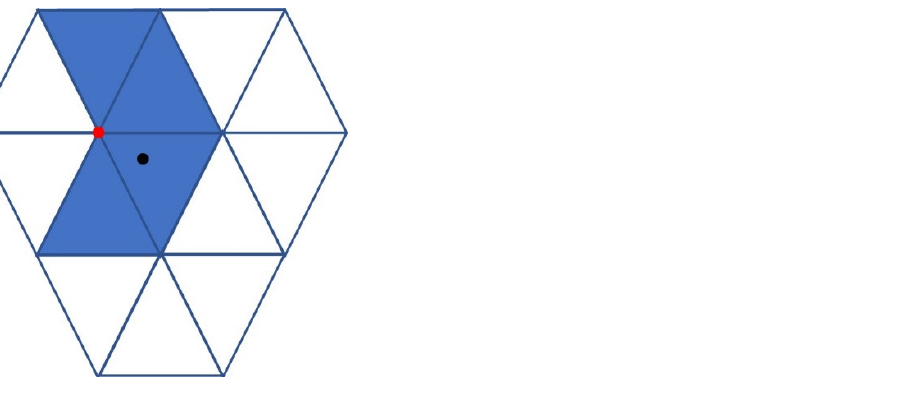
Figure 1. Example of determining the lateral inflows or point sources given the location in longitude or latitude. The black dot represents the given location of the lateral inflow with the shaded triangles indicating the wetted elemental area used in determining the intensity. The red dot indicates the nodal location where this information is included within ADCIRC.